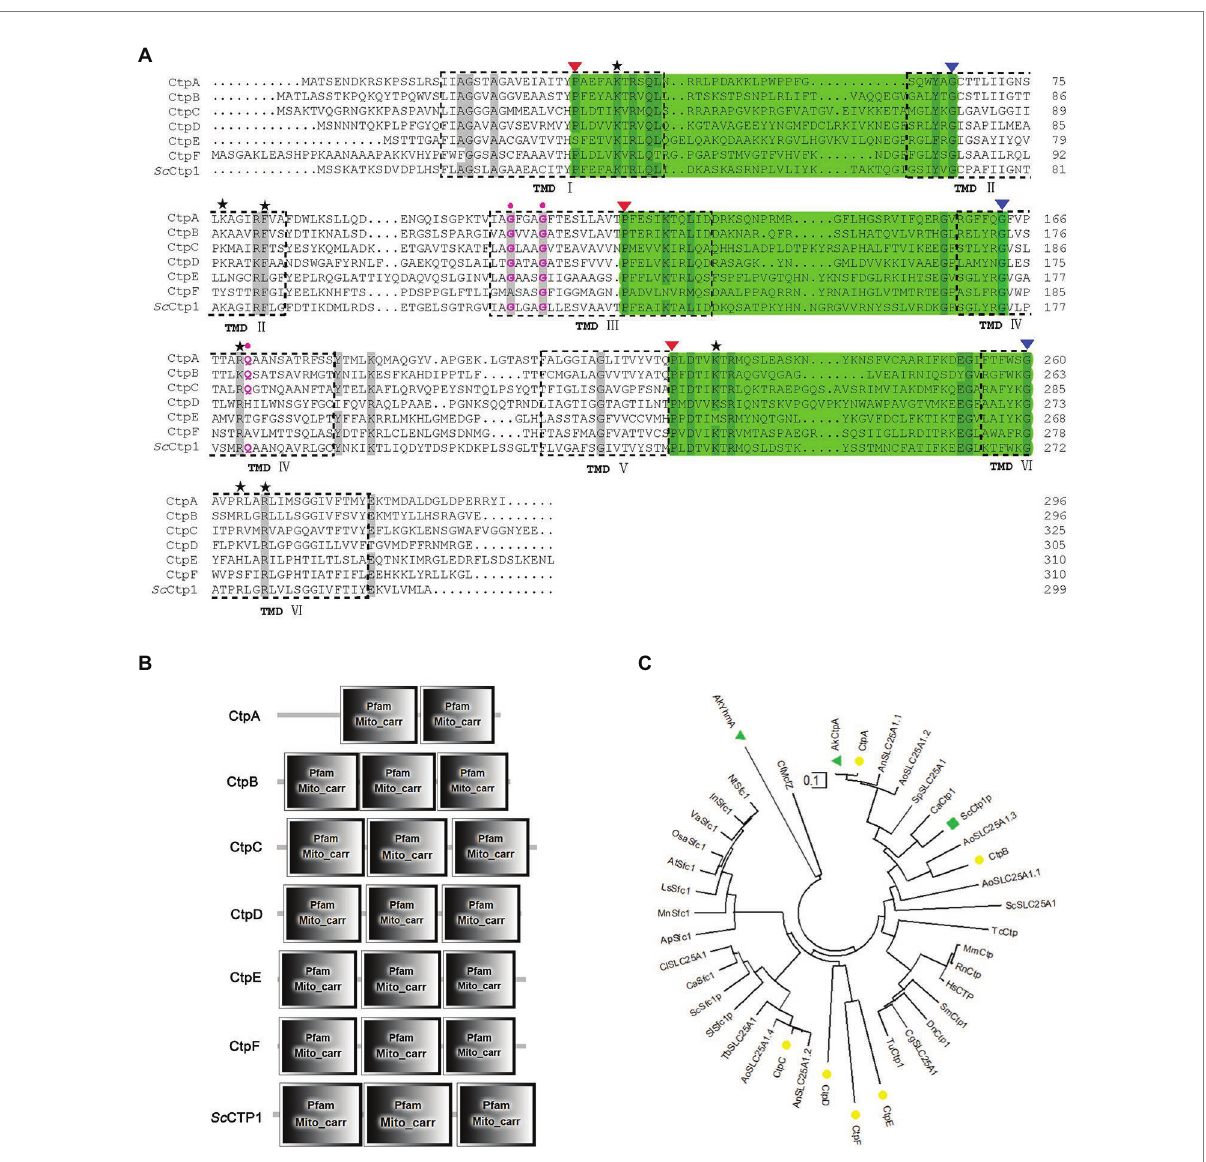
FIGURE 1 Sequence features and domain analyses of CtpA to CtpF. (A) Multiple sequence alignment of CtpA to CtpF amino acid sequence against their yeast ortholog Sc Ctp1. Six predicted transmembrane domains (TMD) based on Sc Ctp1 are marked as TMD I to VI. Note: three symbolic motifs